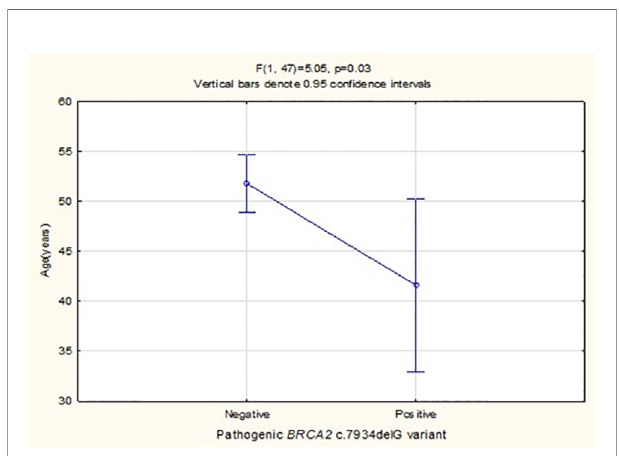
FIGURE 4 | Comparison of the mean age between the fi ve BC patients identi fi ed with BRCA2 c.7934delG founder/recurrent pathogenic variant versus the 45 non-mutation